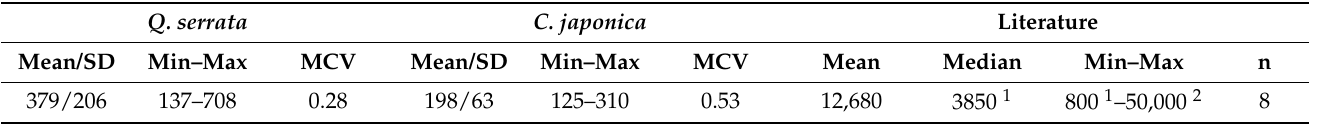
Table 5. Concentrations (ppm) of total sugars in the xylem sap obtained in Experiment 1 and those reported in the